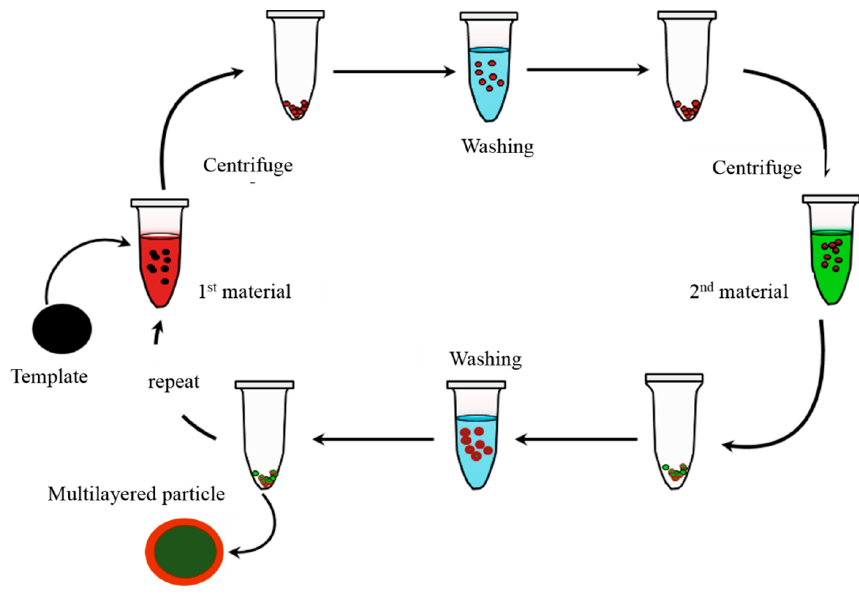
Figure 8. Immersive assembly of the particulate substrate using a centrifugation process with alternate washing steps.